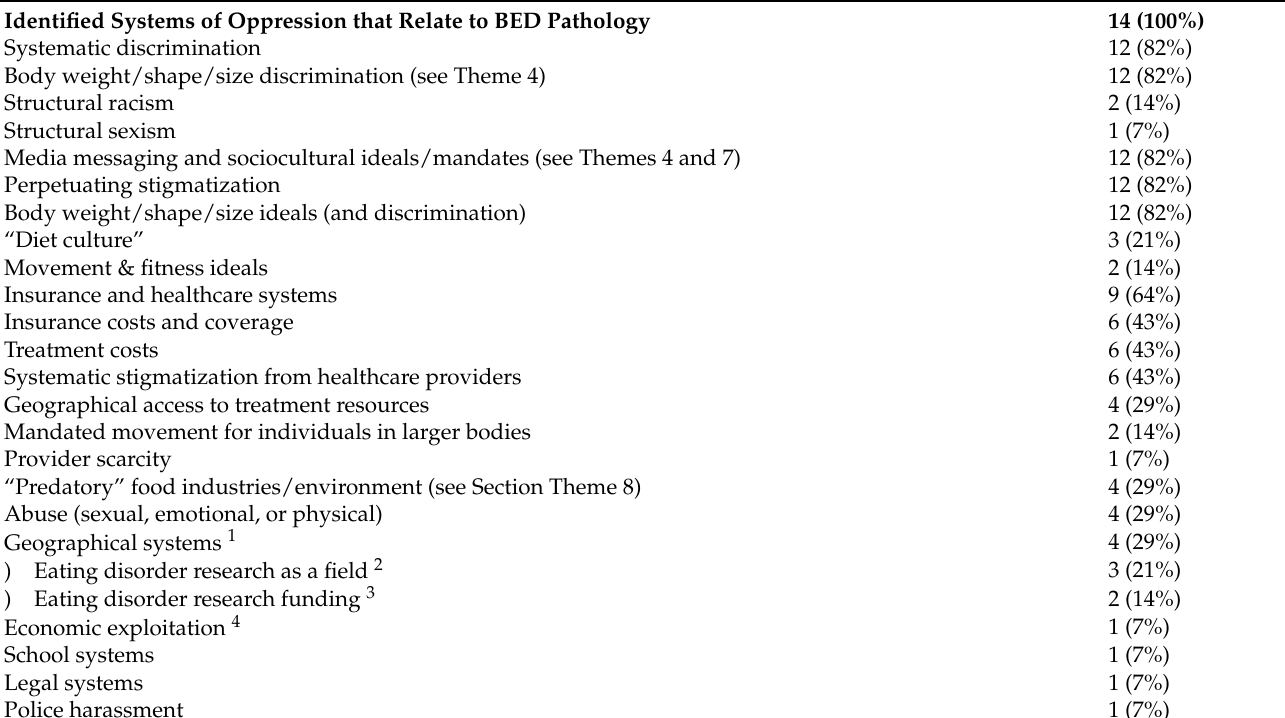
Table 4. Participant responses consistent with Theme 1, “systematic issues and systems of